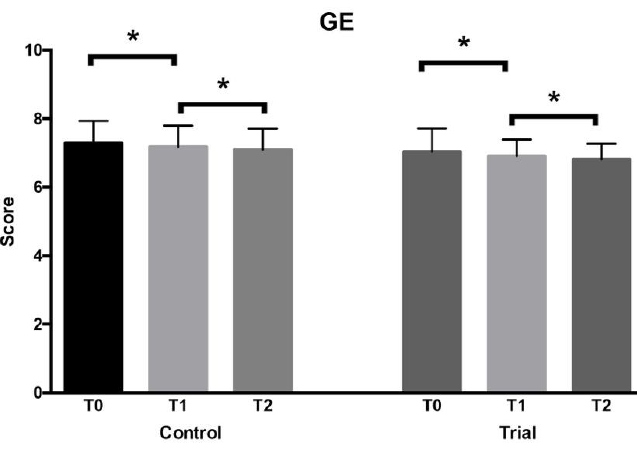
Figure 2. GE values among the time frames of the study. * = p < 0.05. ns = not significant.